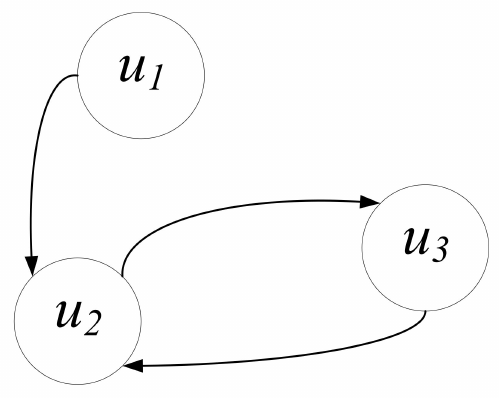
Figure 1. The follow relationship between users in social